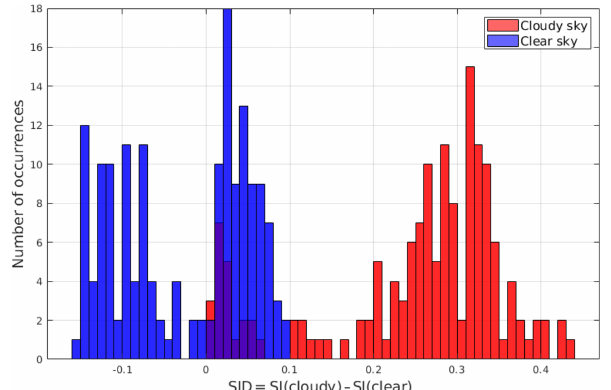
Figure 8. SID occurrence distribution for a subset of tropical spec- tra. The SIDs are computed based on specific (not optimised) train- ing sets. Test set clear-sky spectra are in blue, while cloudy-sky spectra are in red. Cirrus clouds show very small, positive values of the SID, comparable with values obtained for some clear-sky spec- tra. Class membership of test set spectra is known a priori since the dataset is